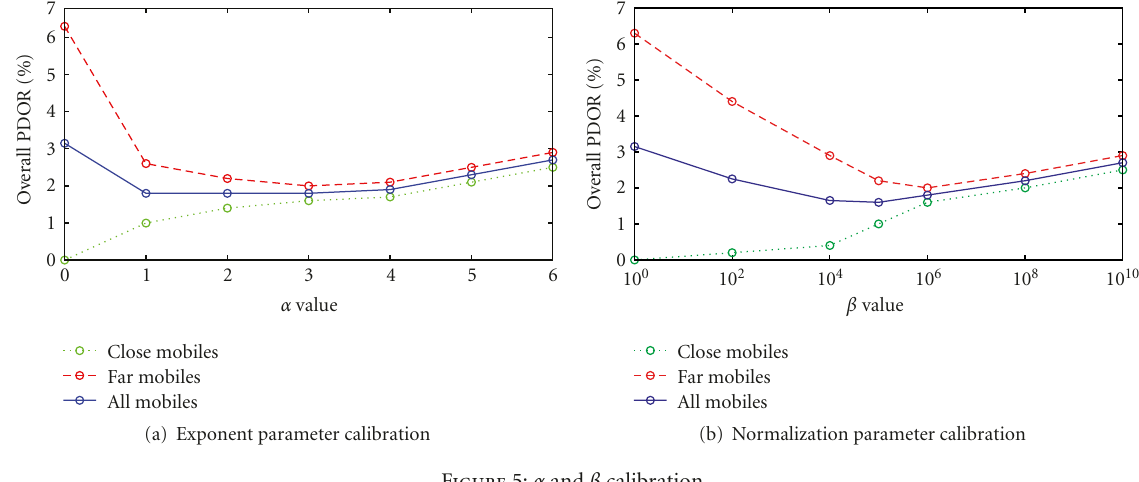
Figure 5: α and β